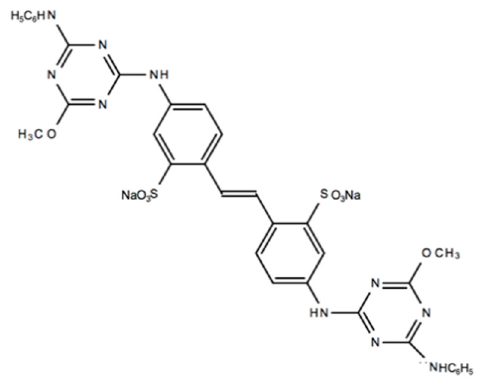
Figure 1. L-PC chemical structure.